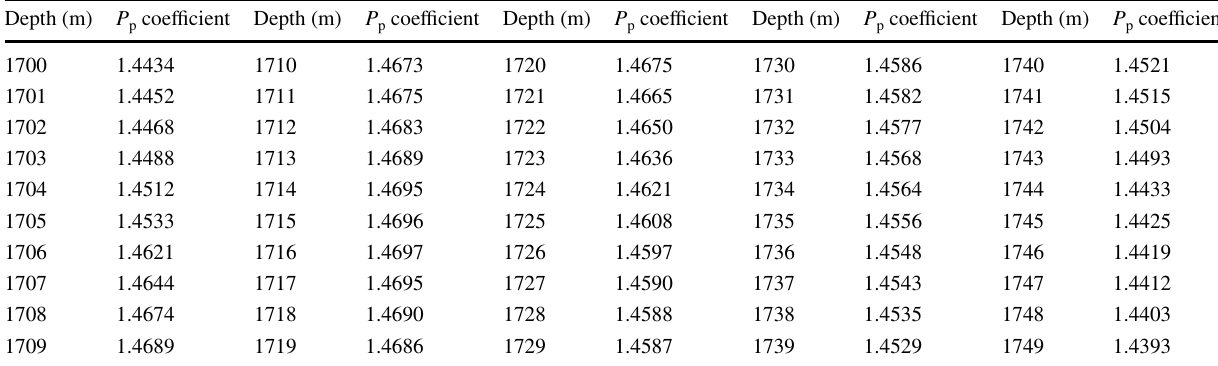
Table 1 Monitoring data of formation pore pressure during drilling from 1700 to 1749